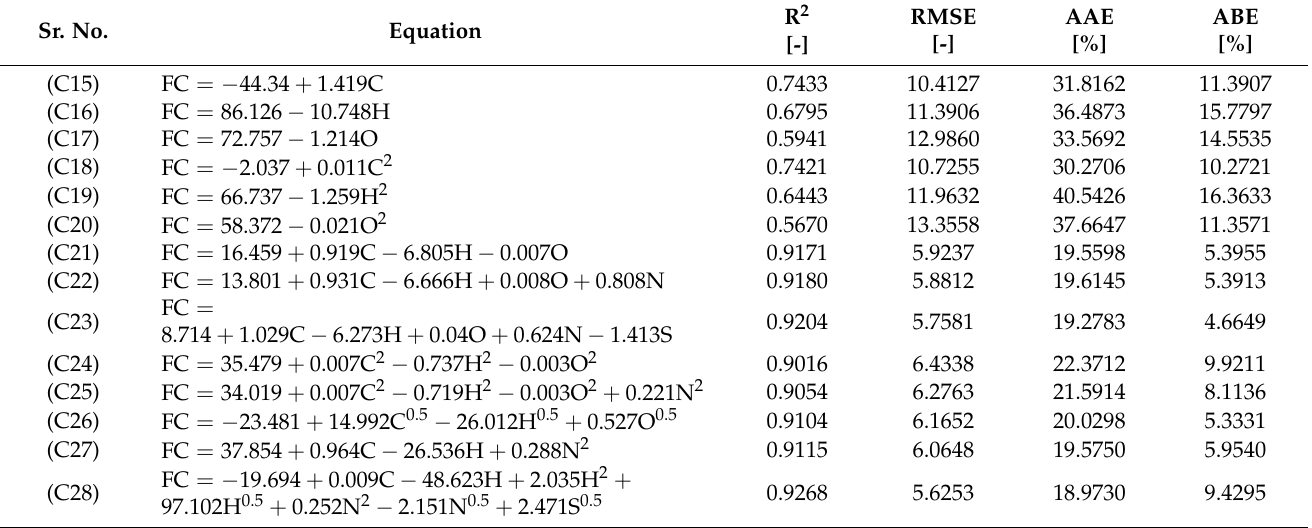
Table 4. Correlations used for predicting the FC of biomass based on element analysis.